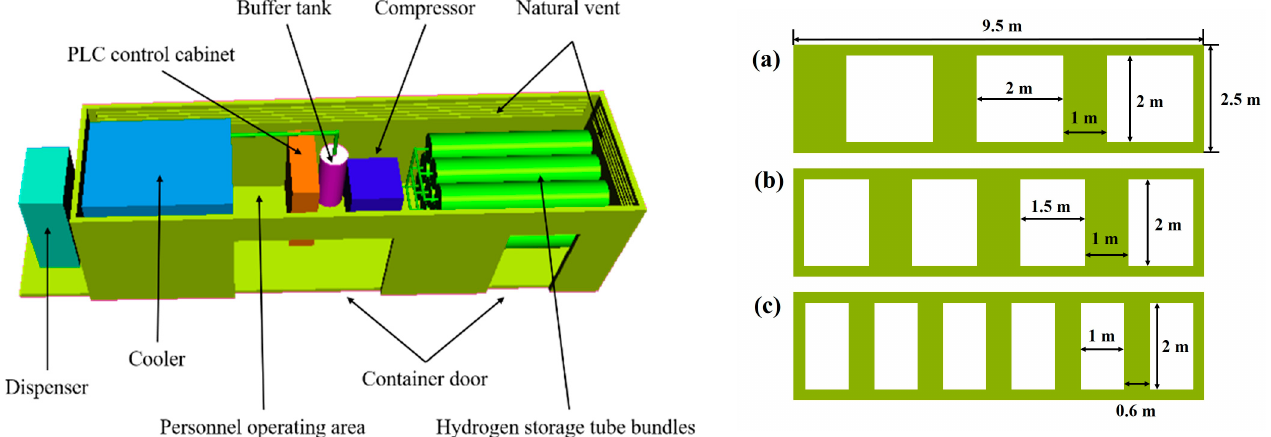
Figure 2. Geometry and explosion vent layouts ( a – c ) of the skid-mounted hydrogen refueling station.